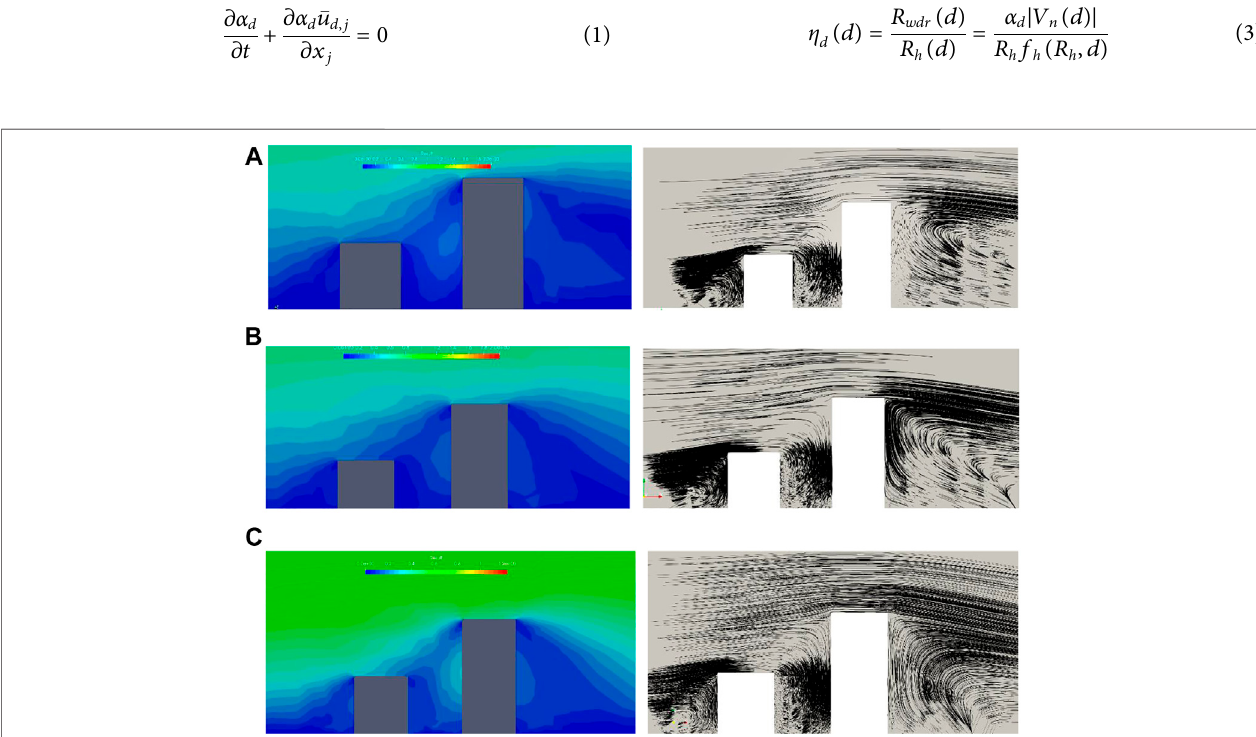
FIGURE2| Normalized velocity ( U / U ref ) distribution and fl owlinedistributionofwind fi eldat differentreferencevelocities: (A) U ref (cid:2) 1m/s, (B) U ref (cid:2) 3m/s,and (C) U ref (cid:2)